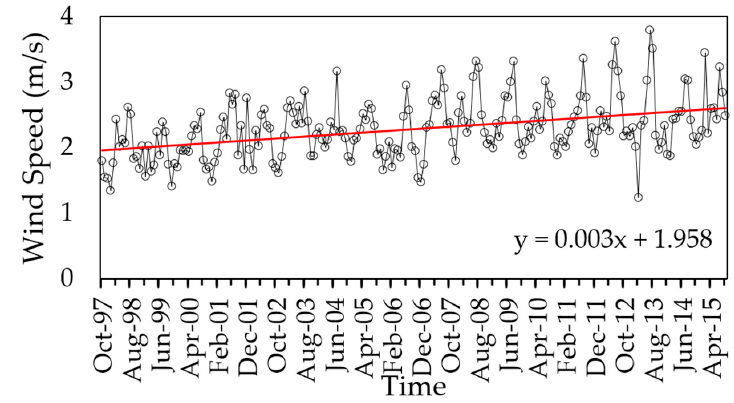
Figure 5. Time series and linear trend analyses of humidity data between 1997 and 2015.